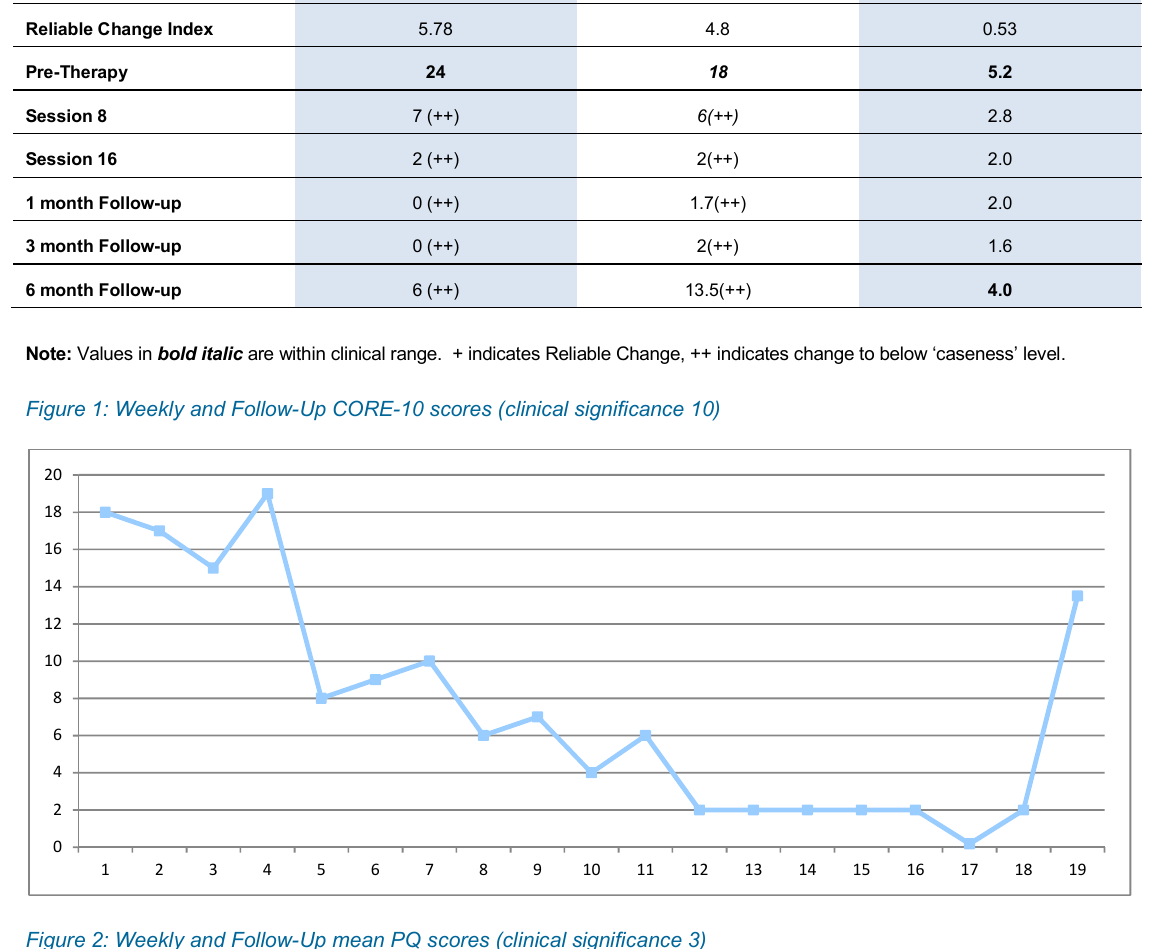
Figure 2: Weekly and Follow-Up mean PQ scores (clinical significance